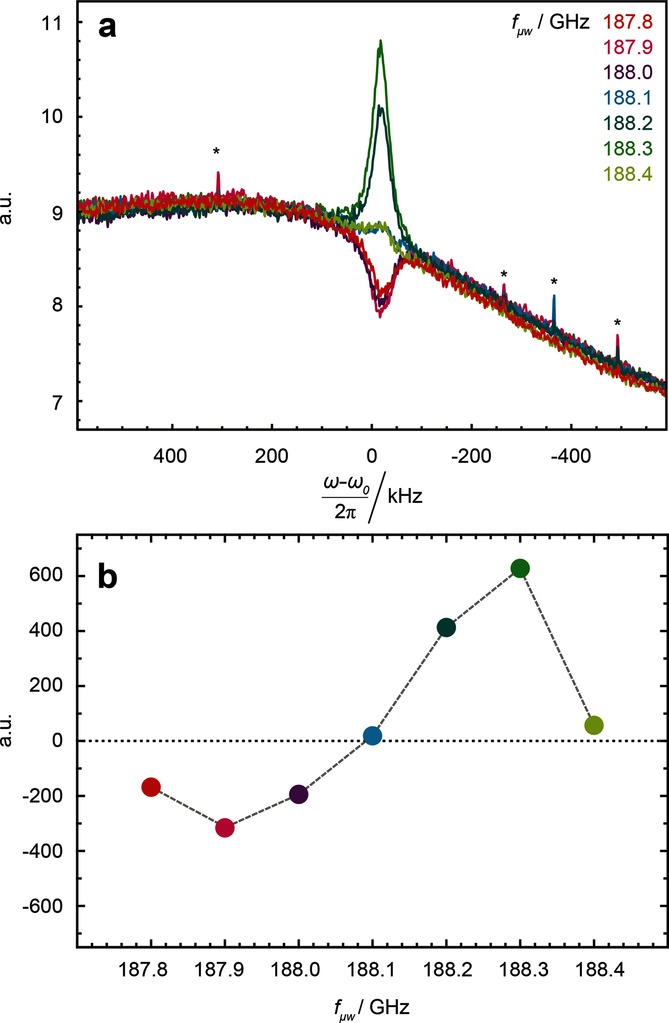
a) Proton (1H) spin noise power spectra, and b) corresponding integrals of these spectra as a function of the microwave irradiation frequency fμw . Asterisks in (a) indicate artifacts stemming from intermittent pick-up from external, unidentified rf sources. In the absence of spin noise the thermal noise gives rise to a non-vanishing baseline.